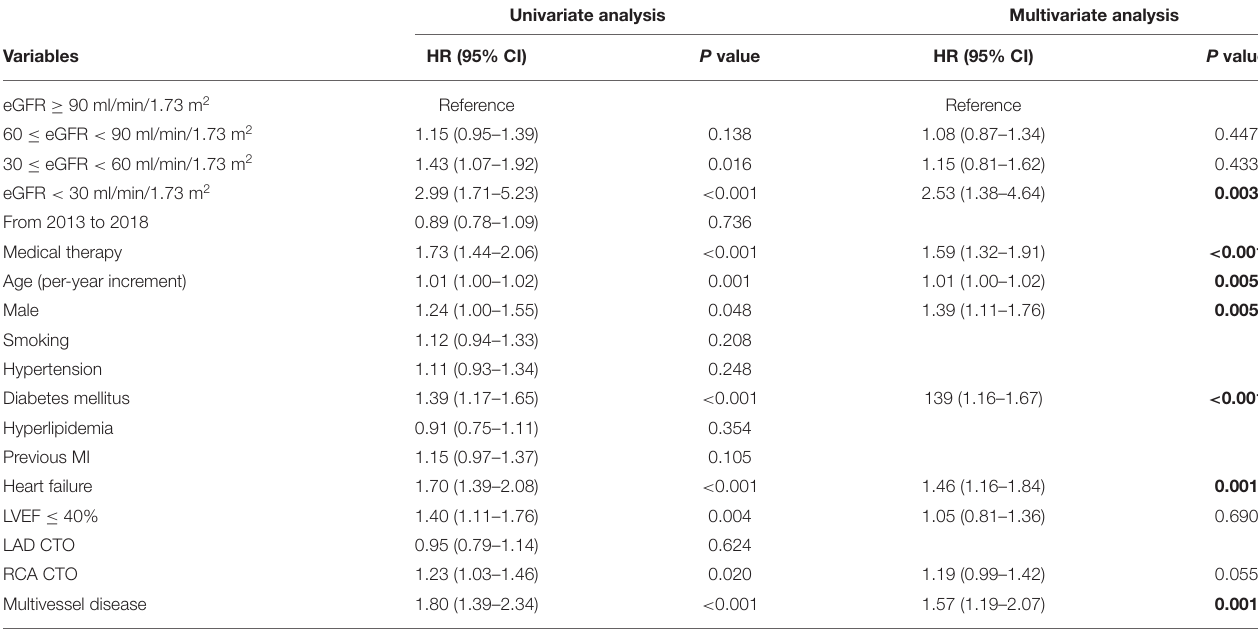
TABLE 6 | Univariate and multivariate analysis for MACE. Univariate analysis Multivariate